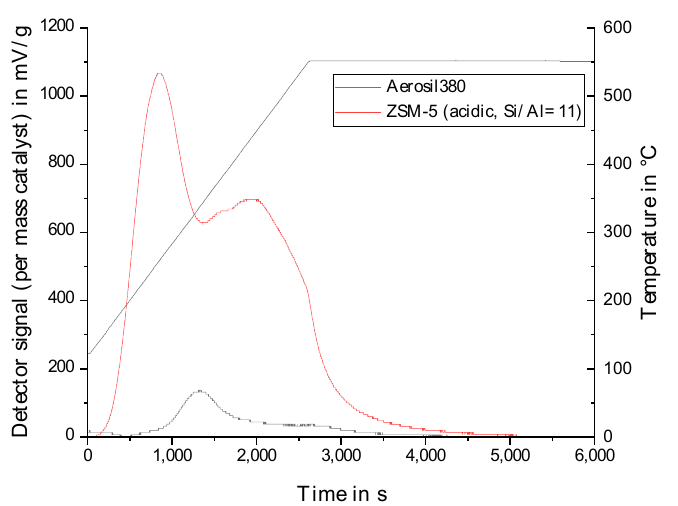
Figure 5. Comparison of the TPAD of Aerosil380 with a commercially available HZSM-5 (Clariant). ZSM-5 = 1260 µmol/g, Aerosil380 = 90 µmol/g.